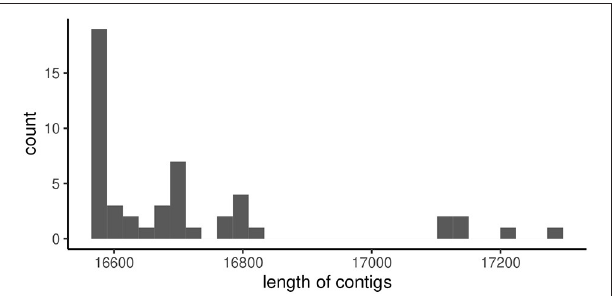
FIGURE 7 | The length of longer contigs generated by Unicycler for random read data generated from MF925724 reference.